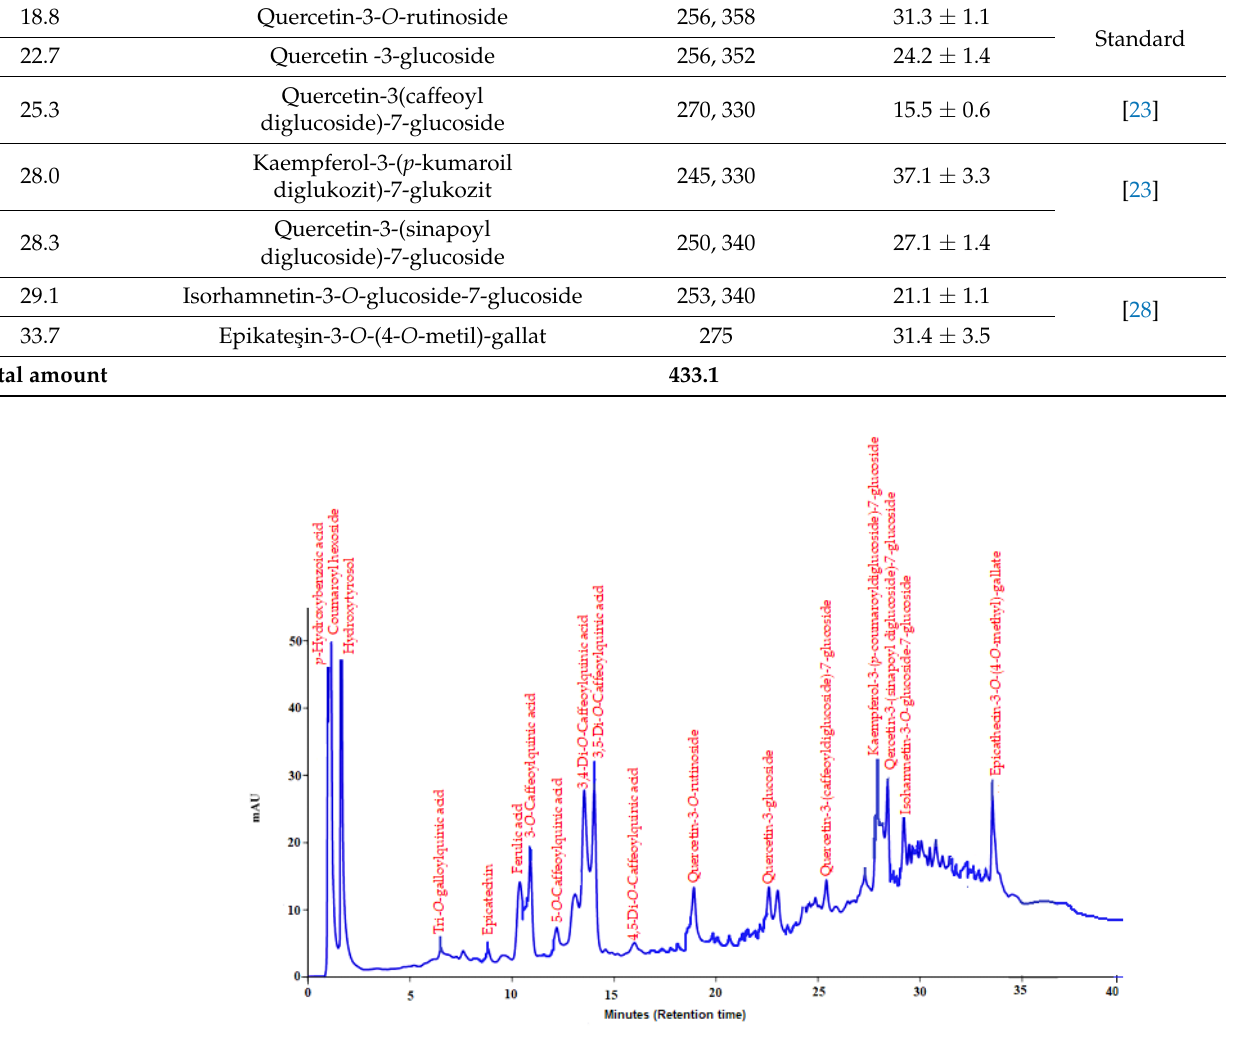
Figure 1. HPLC-DAD chromatogram of methanolic extract prepared from M. neglecta leaves.